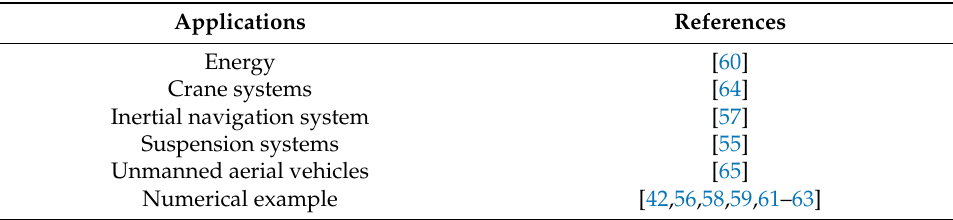
Table 10. Evaluation of multi-state and multi-component systems